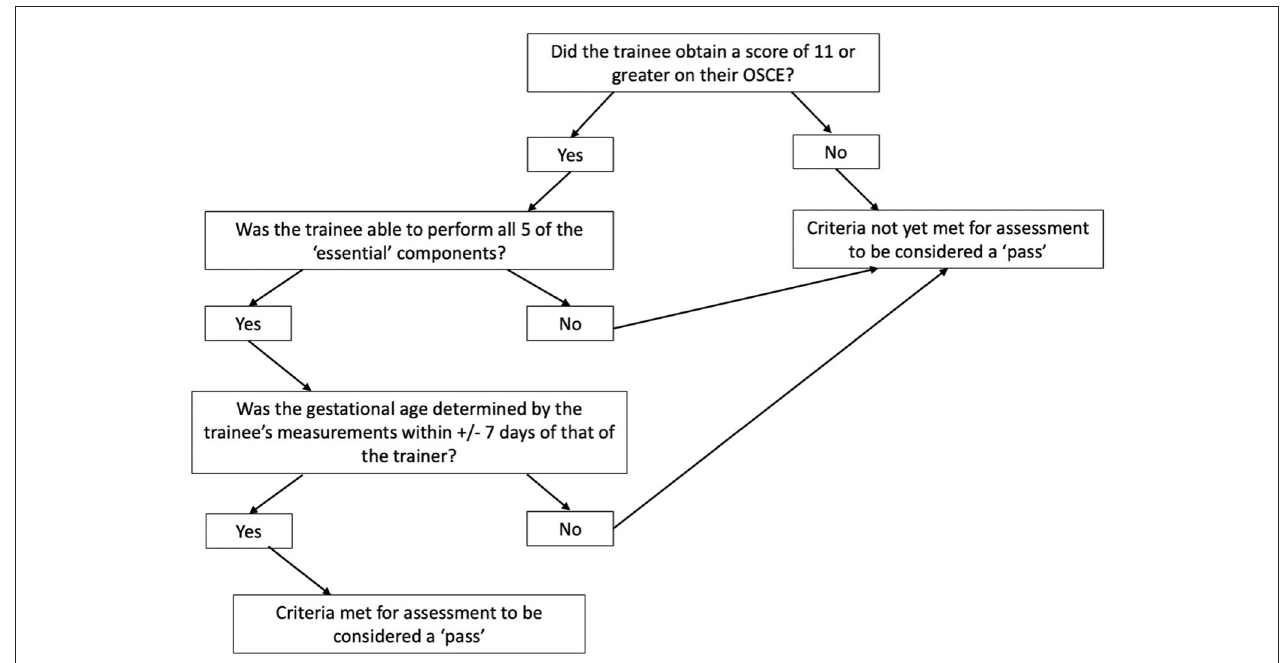
FIGURE 1 | Flowchart depicting methodology of trainee